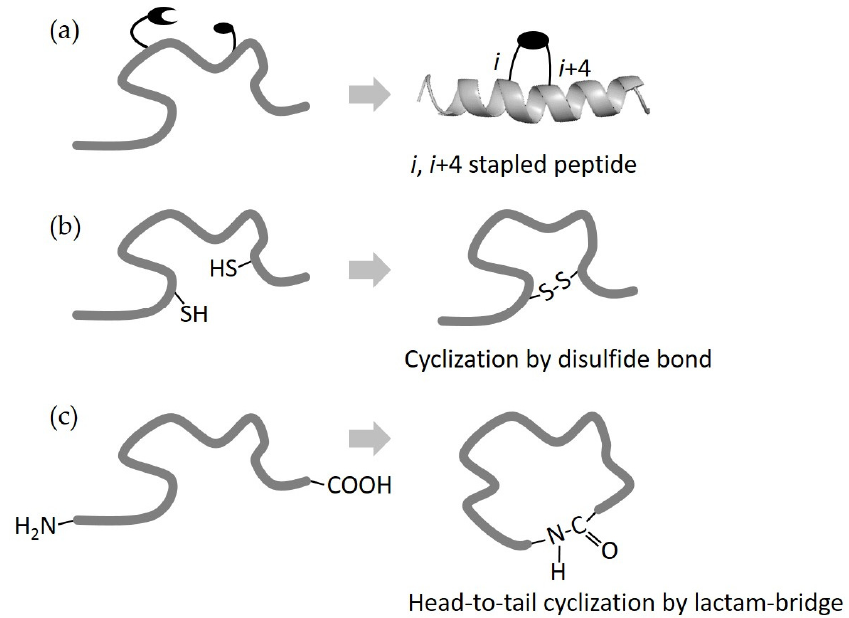
Figure 3. Structural modification. ( a ) Stapled peptide with an external brace across one turn ( i , i + 4), ( b ) cyclization by a disulfide bond, and ( c ) cyclization by a lactam bridge.